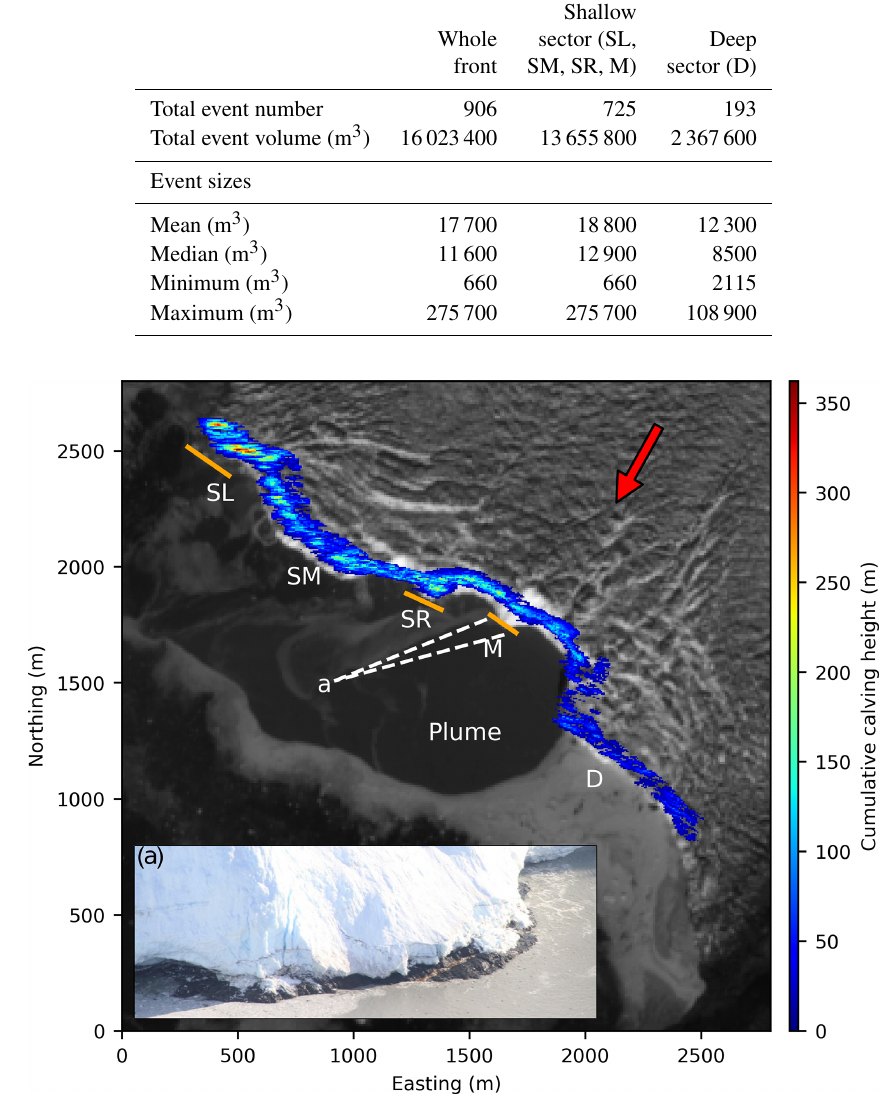
Figure 6. Spatial distribution of cumulative calving height during the 6d measurement period. The capital letters correspond to the sectors of the calving front (see also Fig. 7a). The deep sector (D) shows lower values than the shallow sector. Variations within the shallow sector were used to define the sectors SL, SM, SR, and M. Orange lines indicate areas where bedrock was observed at the base of the front; an example is shown in the inset (position and view angle of inset photograph are indicated by the letter “a” and dashed white lines, respectively). The meltwater plume due to subglacial discharge is very visible. Background: Sentinel-2A scene from 3 August 2016 (from ESA Copernicus Science Hub: https://scihub.copernicus.eu, last access: 14 August